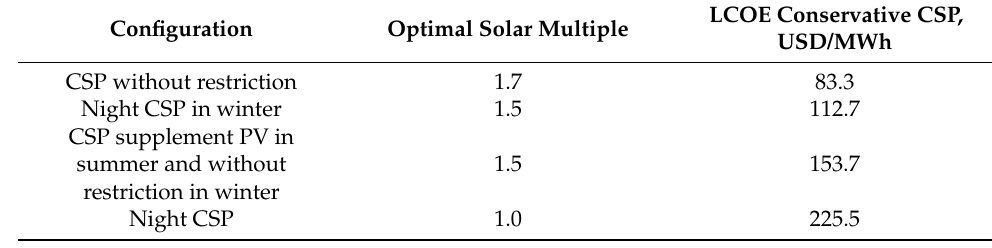
Table 7. Description of case studies.